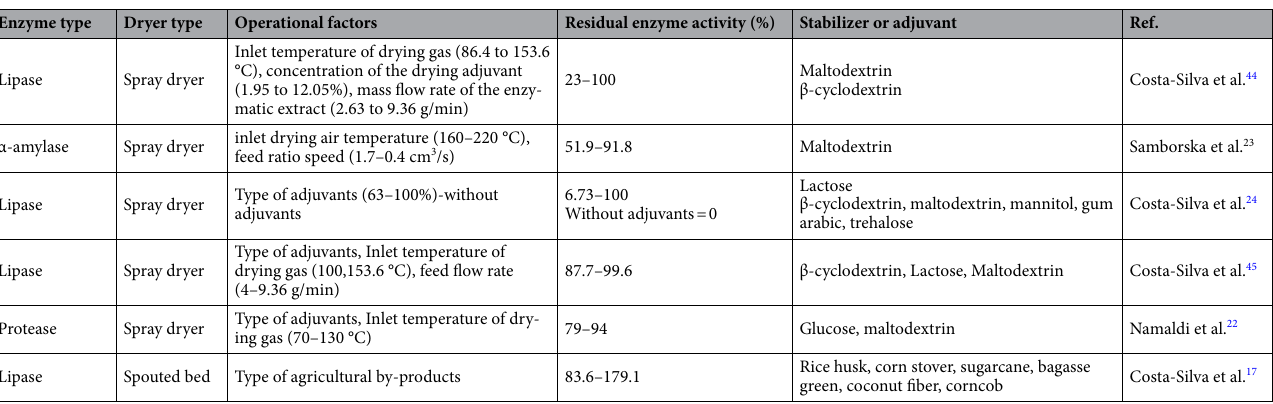
Table 6. Effect of stabilizer agents on the residual enzyme activity in different studies.